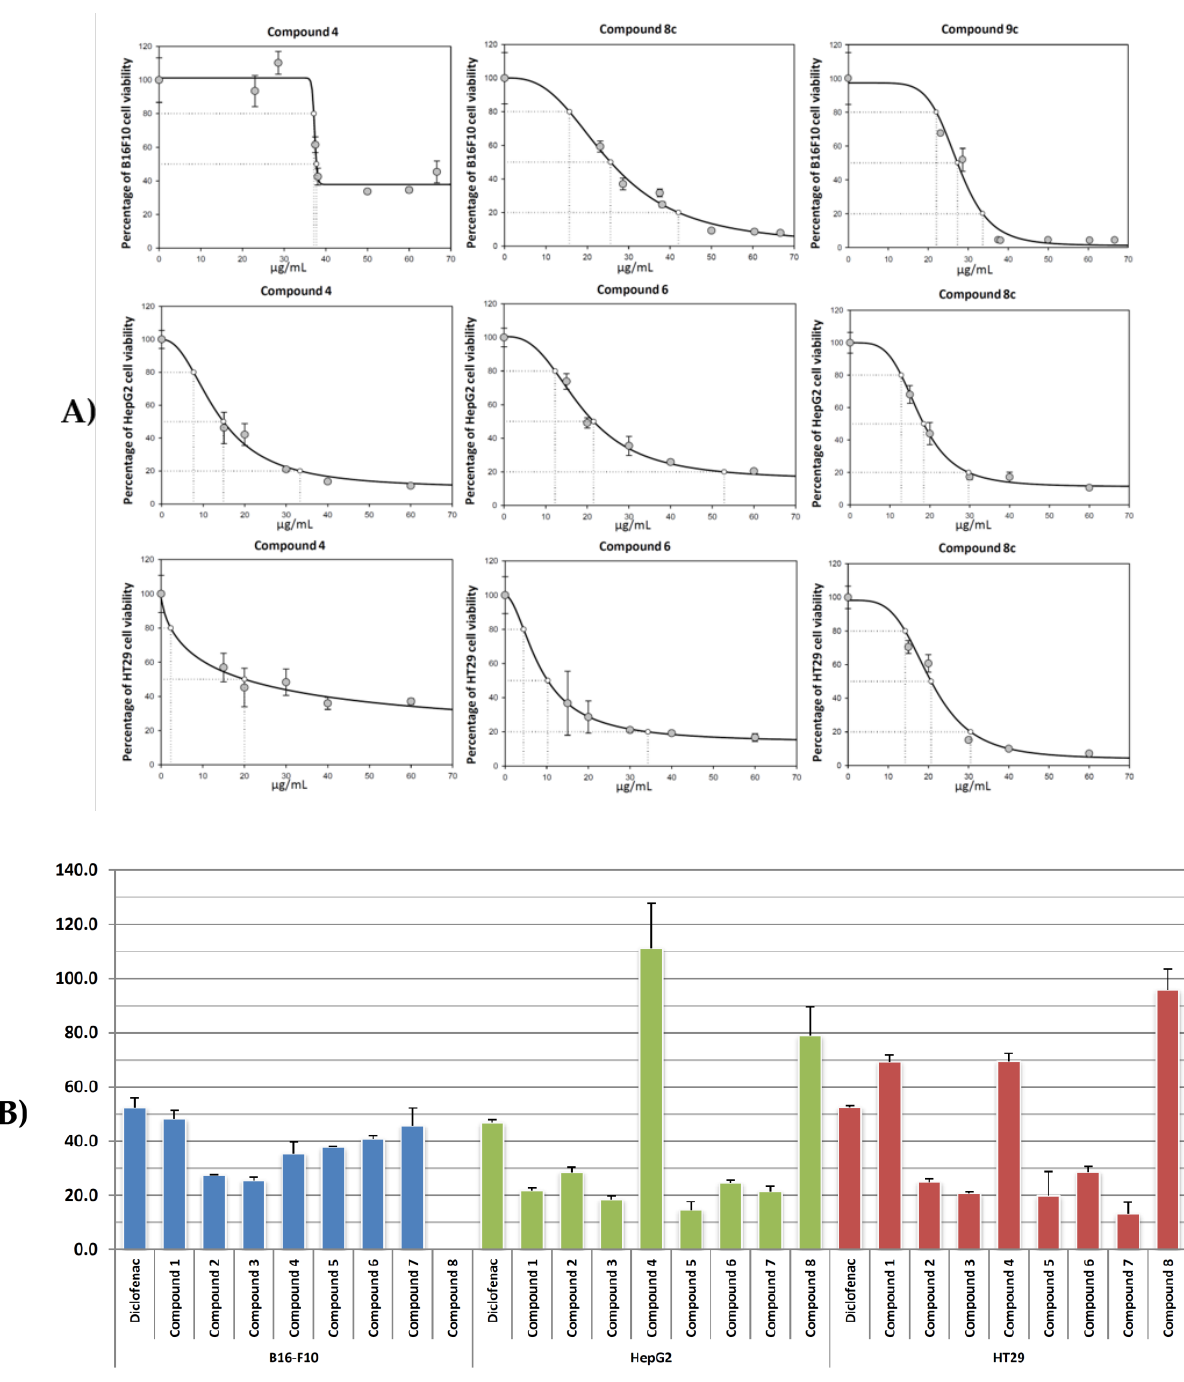
Figure 1. ( A ) Effects of compounds 4 , 8c, and 9c , on the viability of cell B16-F10, and compounds 4 , 6, and 8c on cells HT29 and Hep-G2, after treatment for 72 h in a range of 0 to 100 μg/mL. Each point represents the mean value ± S.D. of at least two independent experiments performed in triplicate. ( B ) IC 50 values ( µ g · mL − 1 ) of compounds 2 , 4 , 6 , 8c , 9c , 10a - c, and DCF on B16-F10, Hep-G2 and HT29 cancer cells.